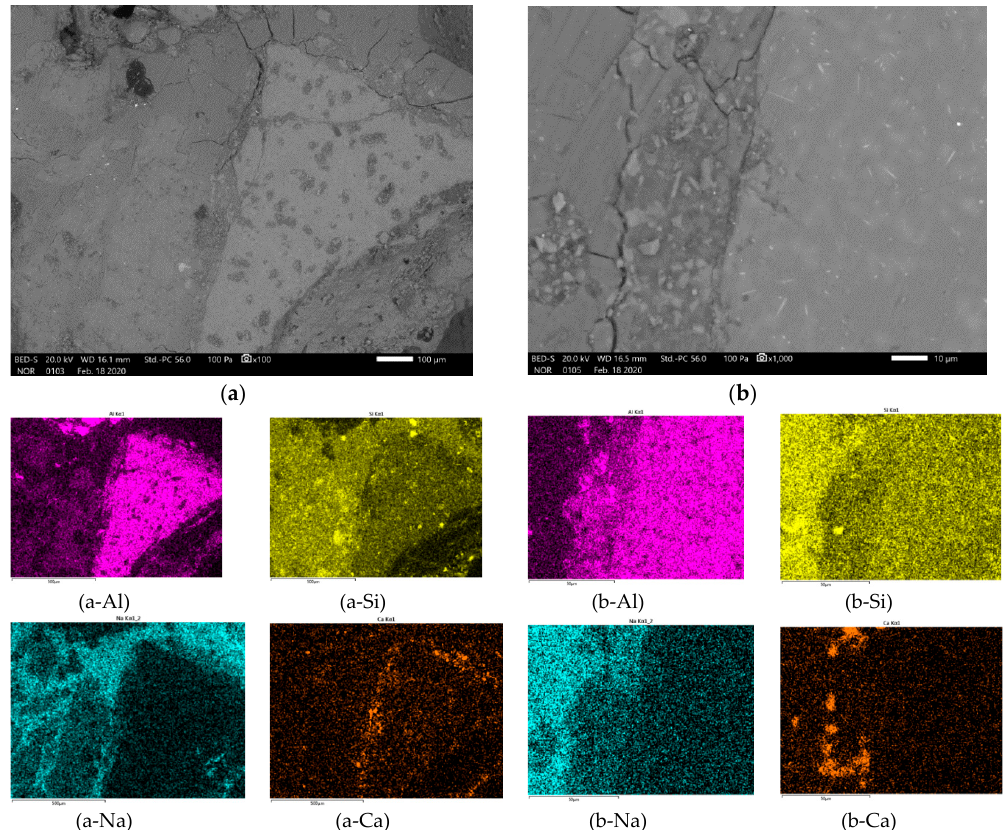
Figure 9. SEM micrograph of alkali activated material prepared from precursor’s fraction 1 mm < x ≤ 2 mm with magnification of ( a ) 100 and ( b ) 1000. EDXS mapping is presented in (b-chemical element) of area (b).